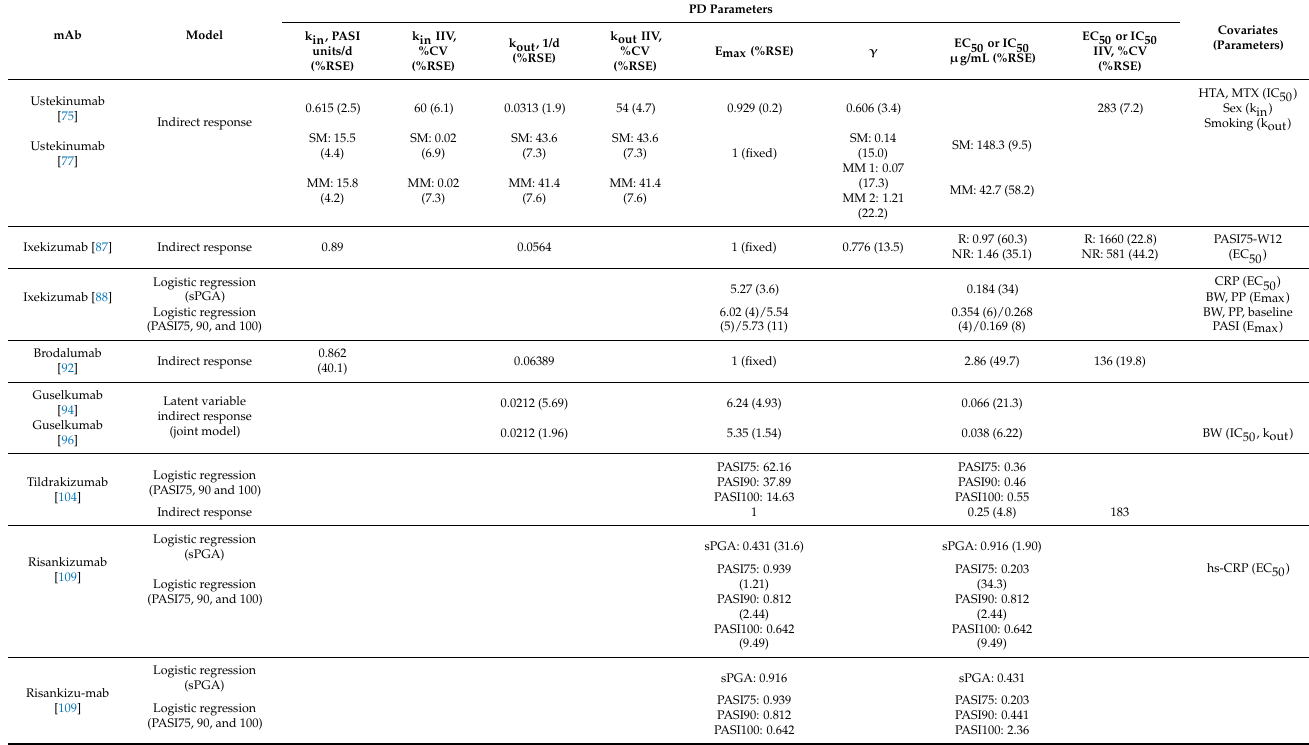
Table 4. Population pharmacodynamic parameters of monoclonal antibodies in